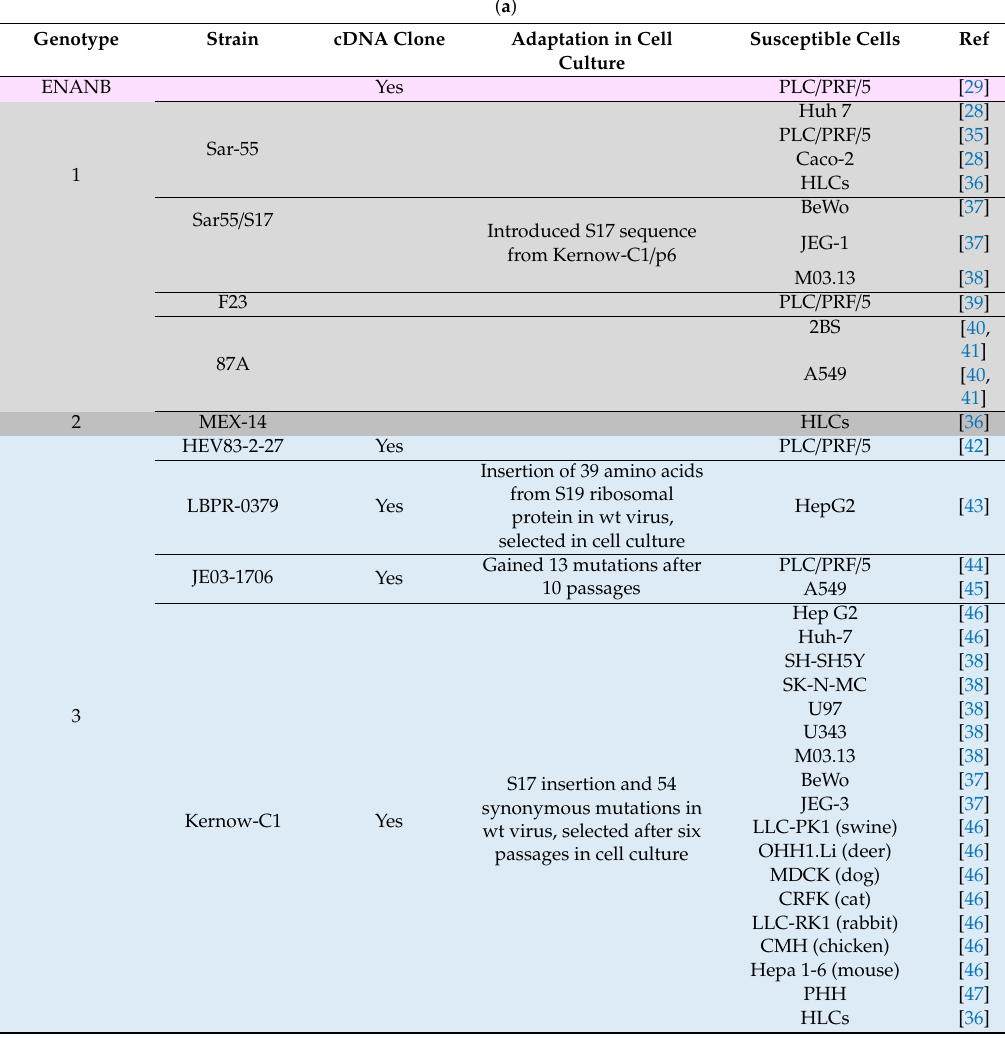
Table 1. Summary of viruses. (a) Hepatitis E virus (HEV) isolates and cDNA clones. HEV strains applied in cell culture and the corresponding susceptible cells. If not stated otherwise, the cells are